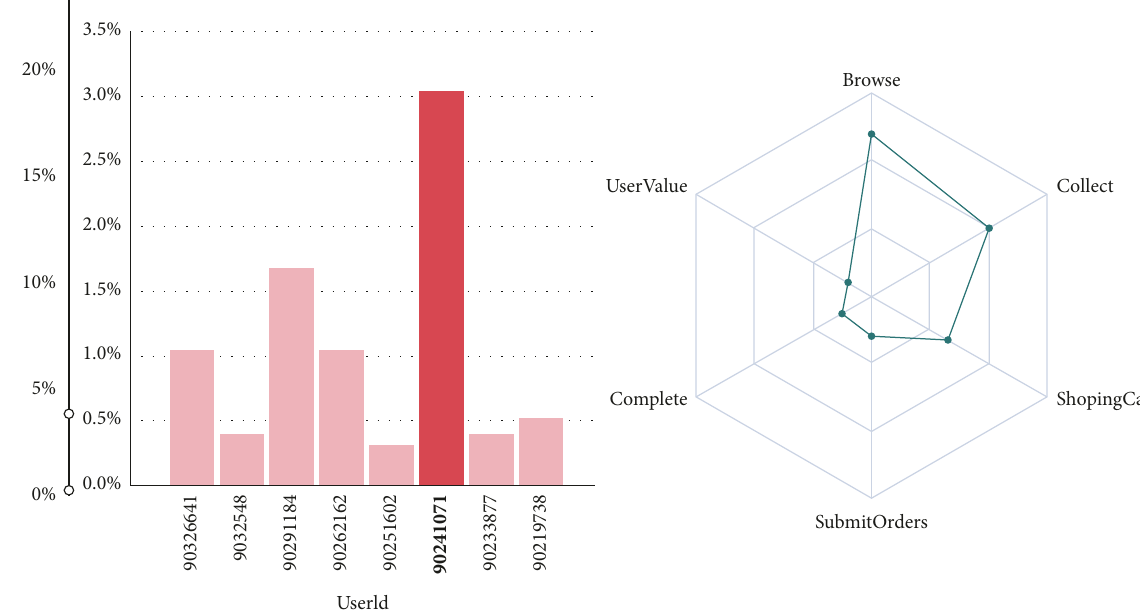
Figure 23: Linkage analysis of individual